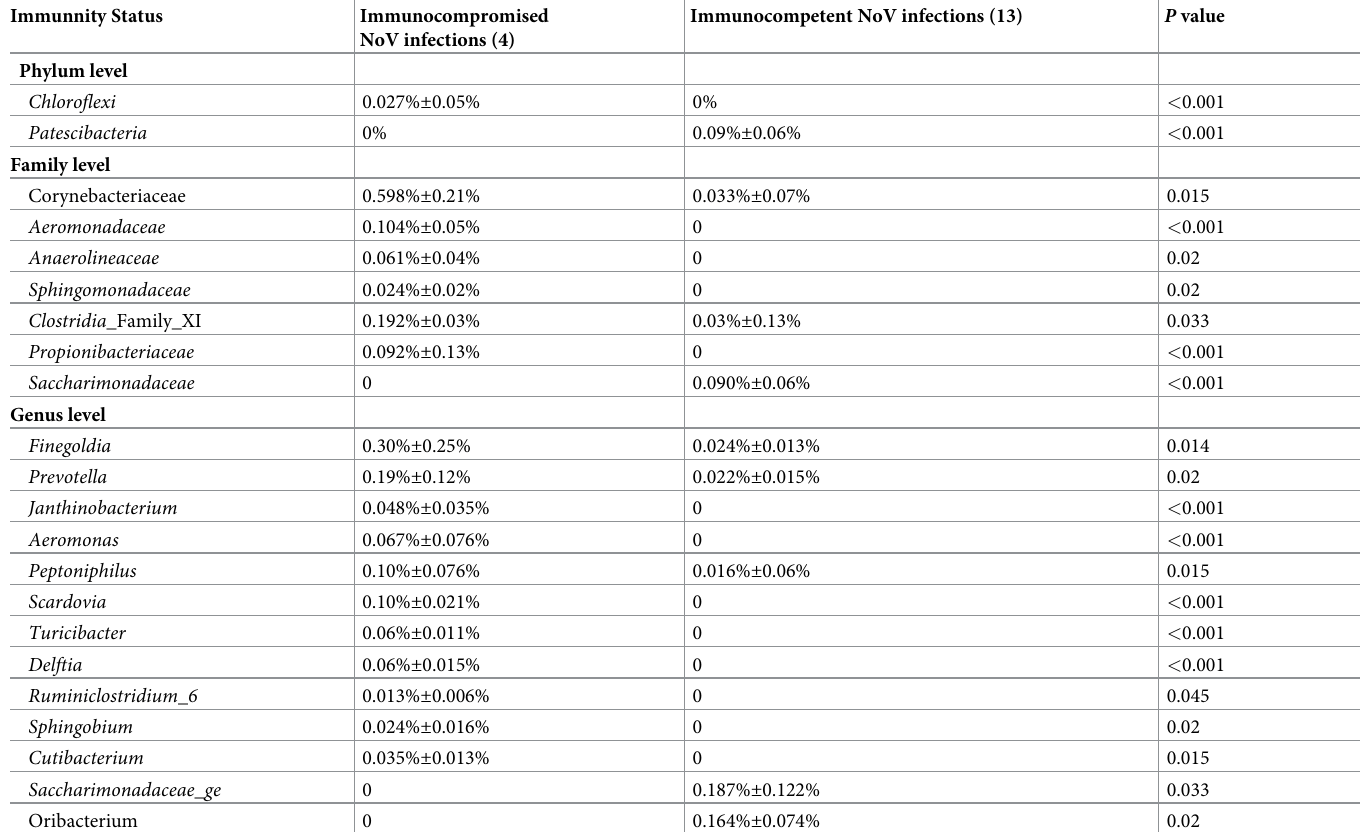
Table 2. Different intestinal microbiota composition at level assignments in children with norovirus gastroenteritis by immunnity